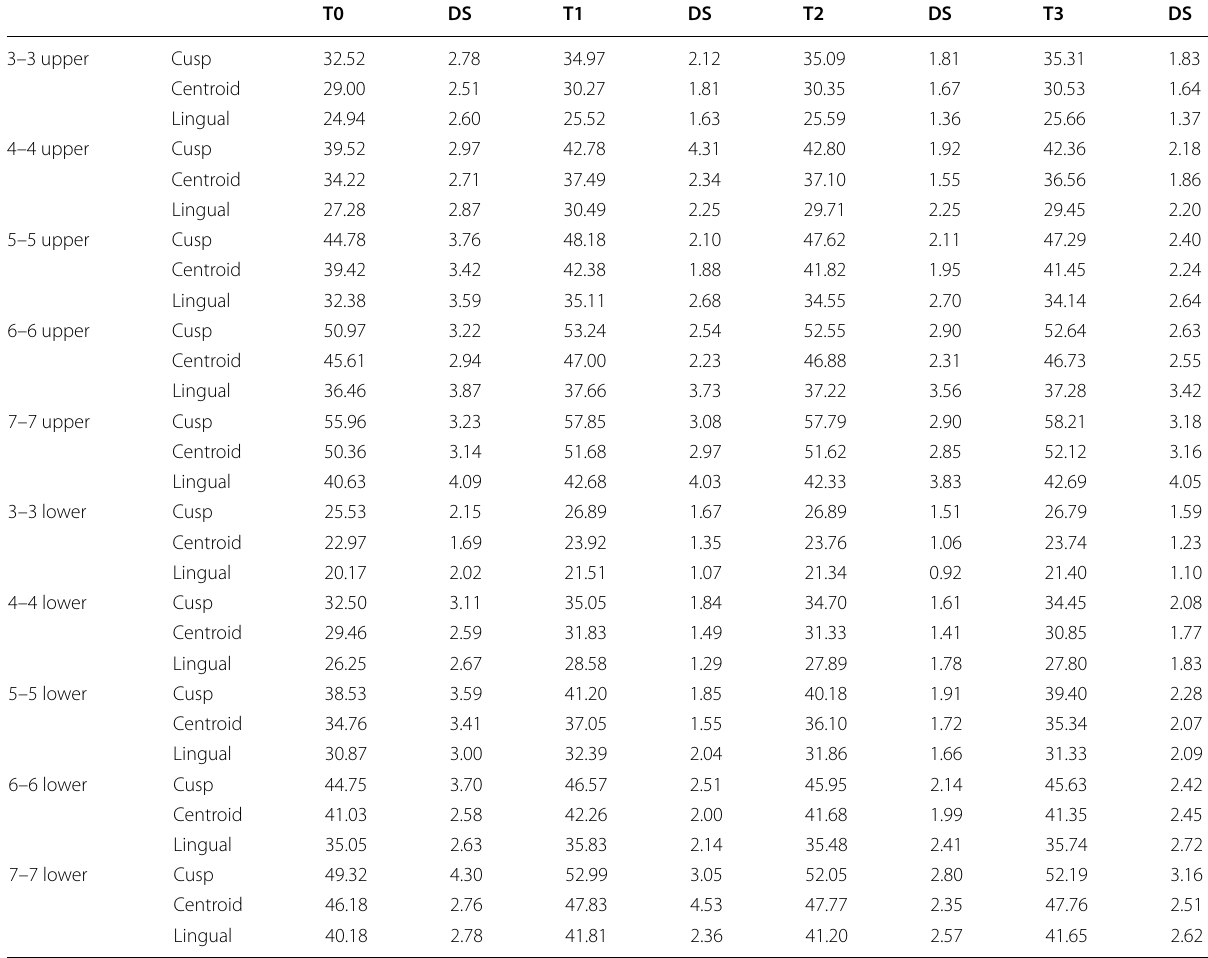
Table 2 Maxillary transverse dimensions (mm) before treatment (T0), immediately after treatment (T1), 1 year after (T2) and 6 years after the end of treatment